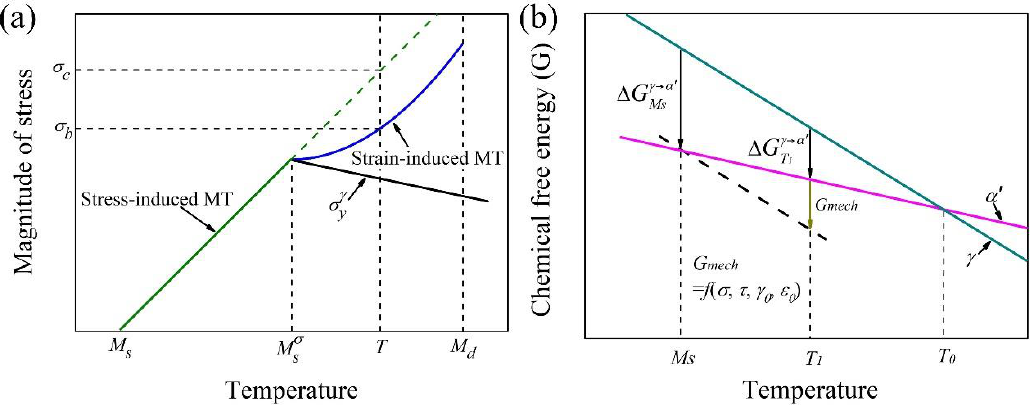
Figure 5. ( a ) Schematic illustration on the definition of stress-induced or strain-induced martensitic transformation (MT) under di ff erent deformation temperatures. ( b ) Schematic illustration of the mechanisms of stress-induced martensitic transformation [92].